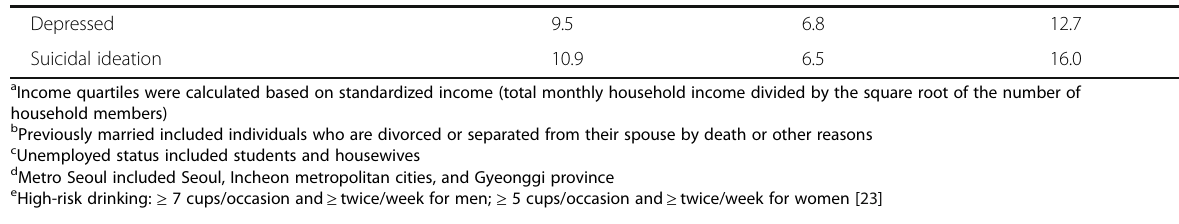
Table 1 Descriptive characteristics of a sample of young South Korean adults aged 20 to 39 years – 2010 – 12 Korea National Health and Nutrition Examination Survey (KNHANES) ( N = 6055) (Continued)